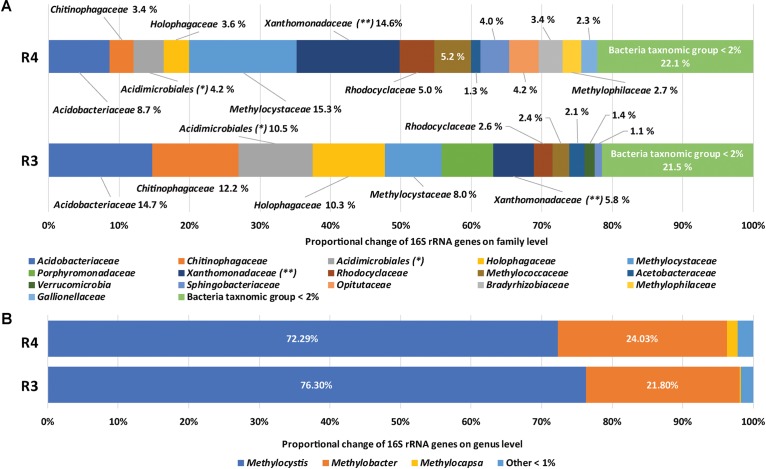
Taxonomic assignments of 16S rRNA gene sequences of methanotrophic enrichment cultures. Relative compositions of microbial communities (A) and methane-oxidizing bacteria (B) in R4 and R3, respectively. ∗ indicates unknown family of Acidimicrobiales, ∗∗ indicates Xanthomonadaceae and unknown family of Xanthomonadale.